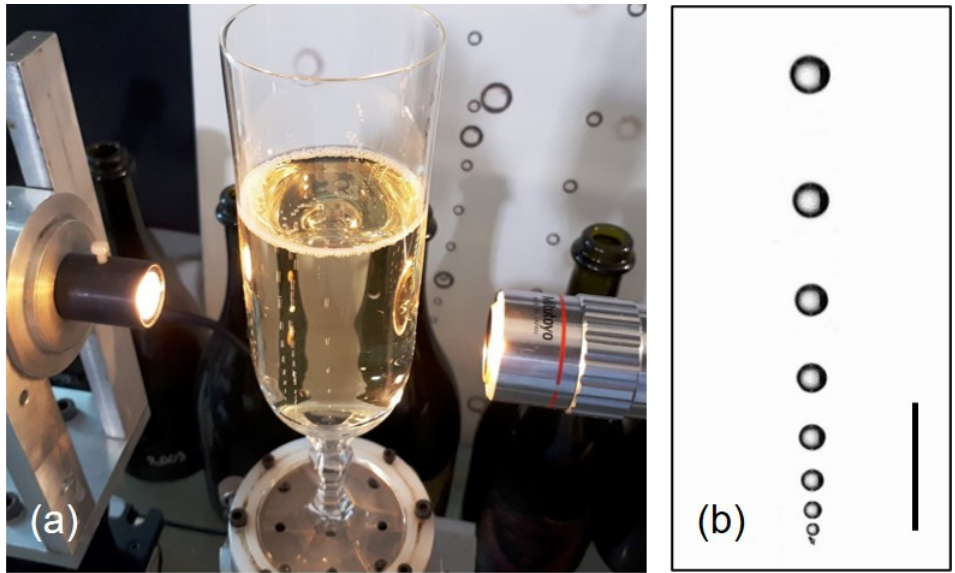
Figure 1. High-speed video imaging device aimed at filming ascending bubbles in glasses poured with sparkling wines ( a ), with a micrograph showing CO 2 bubbles rising in-line and growing by diffusion along the side of the glass ( b ) (bar = 1 mm). (photographs by G.